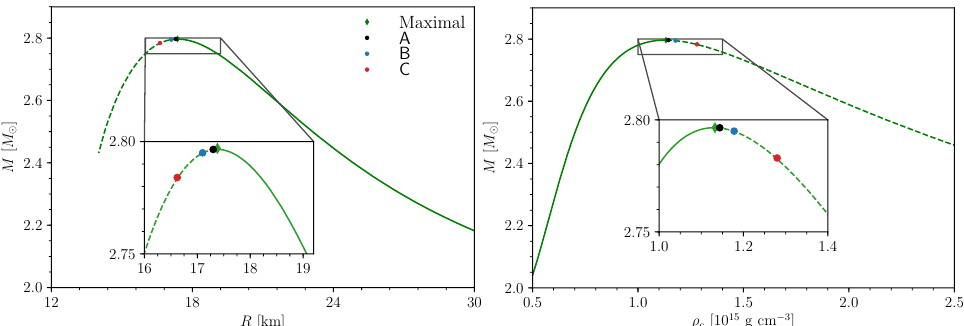
Figure 1. TOV solutions for the SHT-NL3 EoS in neutrino-less β -equilibrium and constant T = 30 MeV. The marked points refer to the configurations of Table 1: maximal (green diamond), A (black circle), B (blue circle), and C (red circle). Left panel: mass-radius curve. Right panel: mass- central rest-mass density curve. The solid line represents the stable branch, while the dashed line represents the unstable